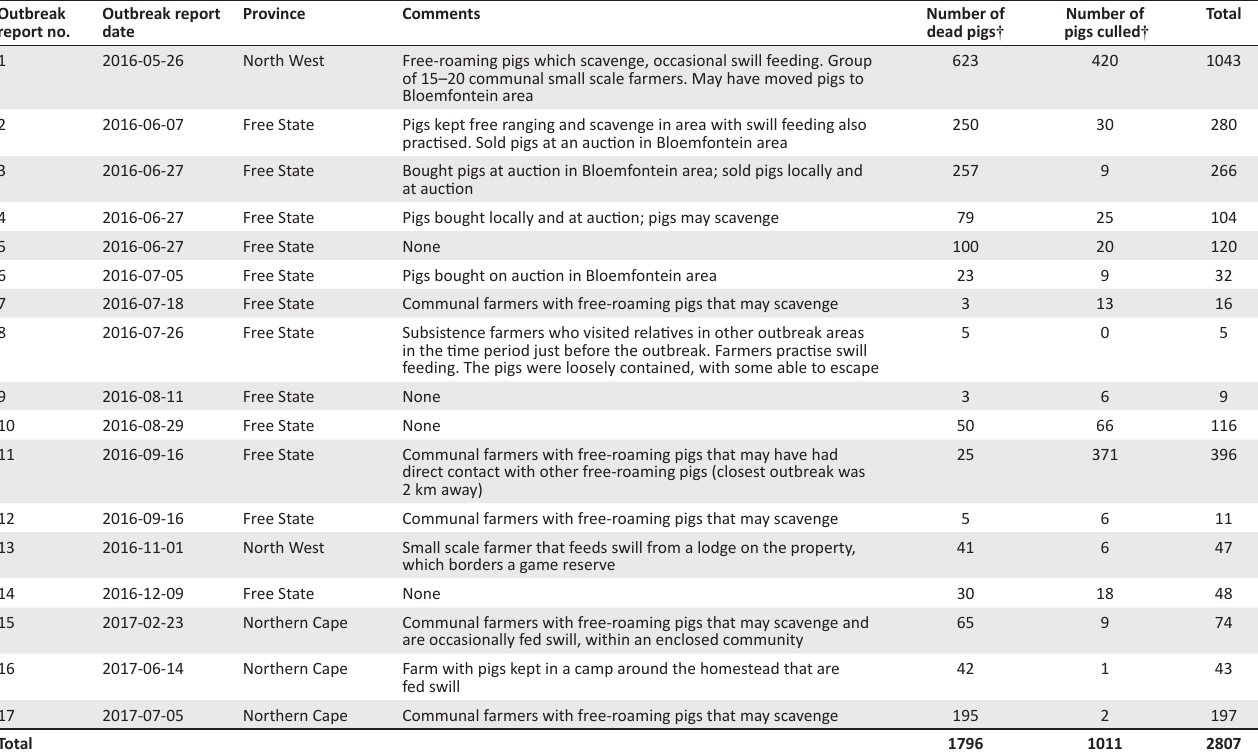
TABLE 2: Summary of the 2016–2017 African swine fever epidemic outside the South African controlled area. Outbreak report no.